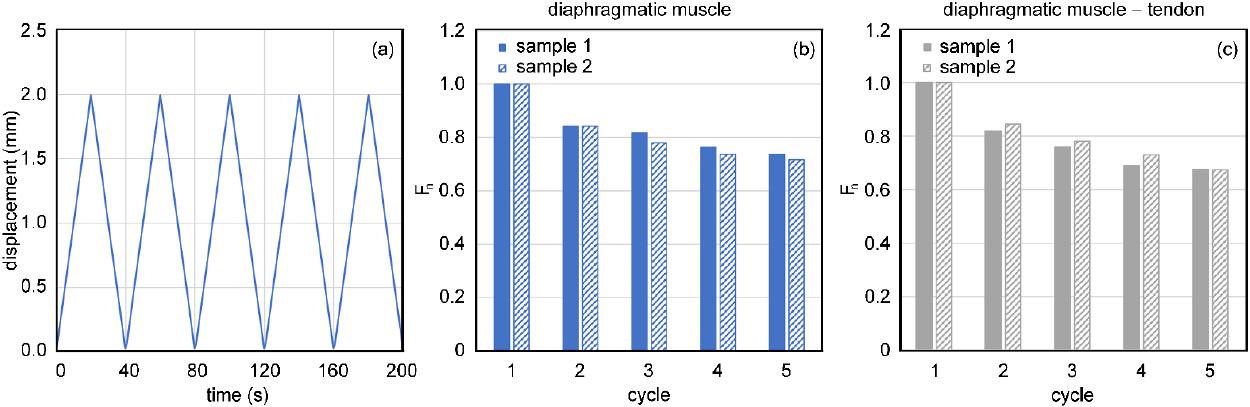
Figure 5. Cyclic loading of diaphragmatic muscle tissue attached with sutures: loading–unloading protocol ( a ); the displacement refers to the movement of each linear actuator of the setup, corresponding to a maximum elongation of the sample of 4 mm. Values of peak normalized force F n for each loading cycle ( b , c ). The force values are normalized to the peak force in the first cycle of the loading